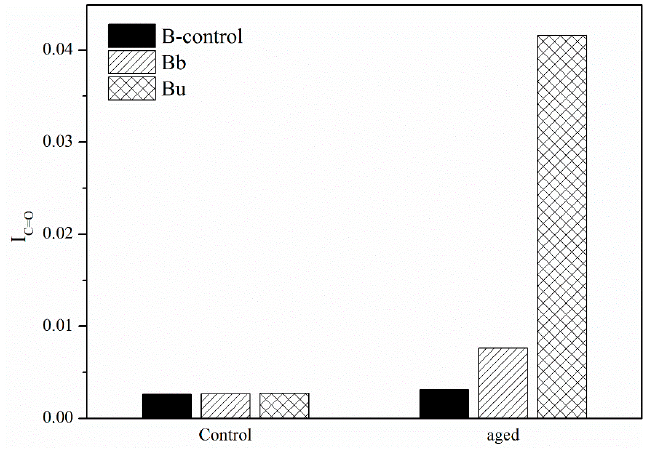
Figure 9. I C=O of the second group before and after UV aging. Figure 9. I